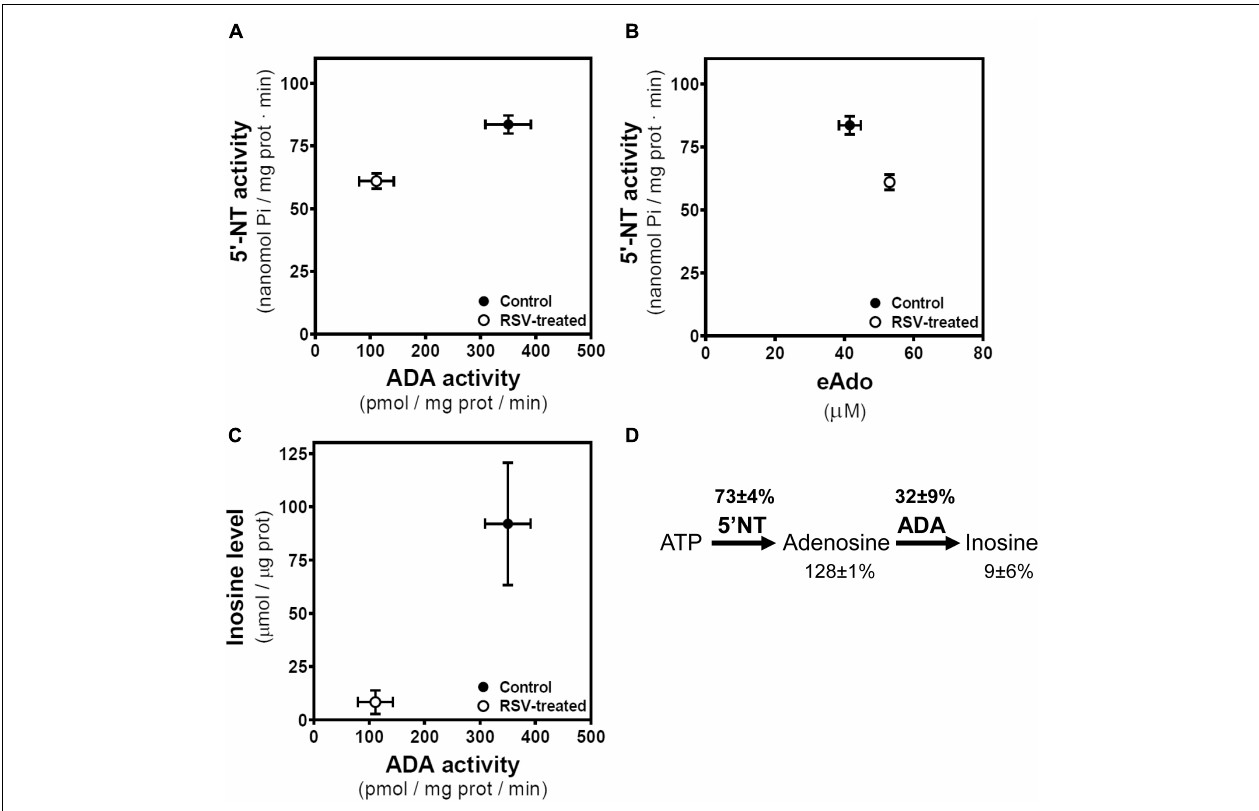
FIGURE 8 | Associations between enzymatic activities and related metabolites. (A) Mean values with SEM bars of 5 (cid:48) -nucleotidase (5 (cid:48) -NT) and ADA activities derived from control and RSV treated cells. (B) Mean values with SEM bars of 5 (cid:48) -nucleotidase (5 (cid:48) -NT) and extracellular adenosine (eAdo) levels derived from control and RSV-treated cells. (C) Mean values with SEM bars of inosine levels and ADA activity derived from control and RSV treated cells. (D) Levels of adenosine and inosine and 5 (cid:48) NT and ADA activities in RSV treated cells are expressed as the percentage of the corresponding control